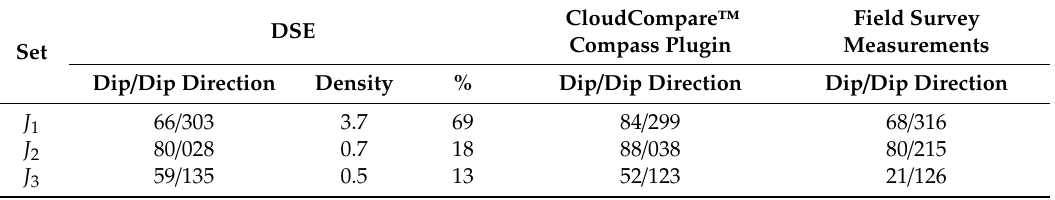
Table 2. Discontinuity sets and their characteristics in terms of dip and dip direction resulted from field-based and point cloud-based structural